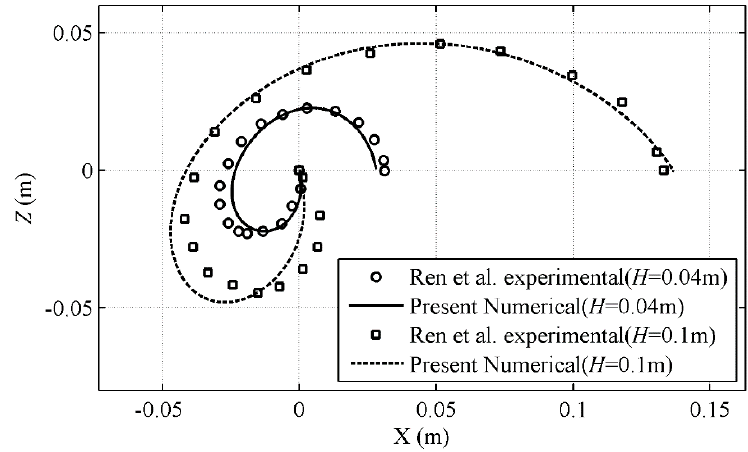
Figure 5. The trajectory of the floating box in a motion period.